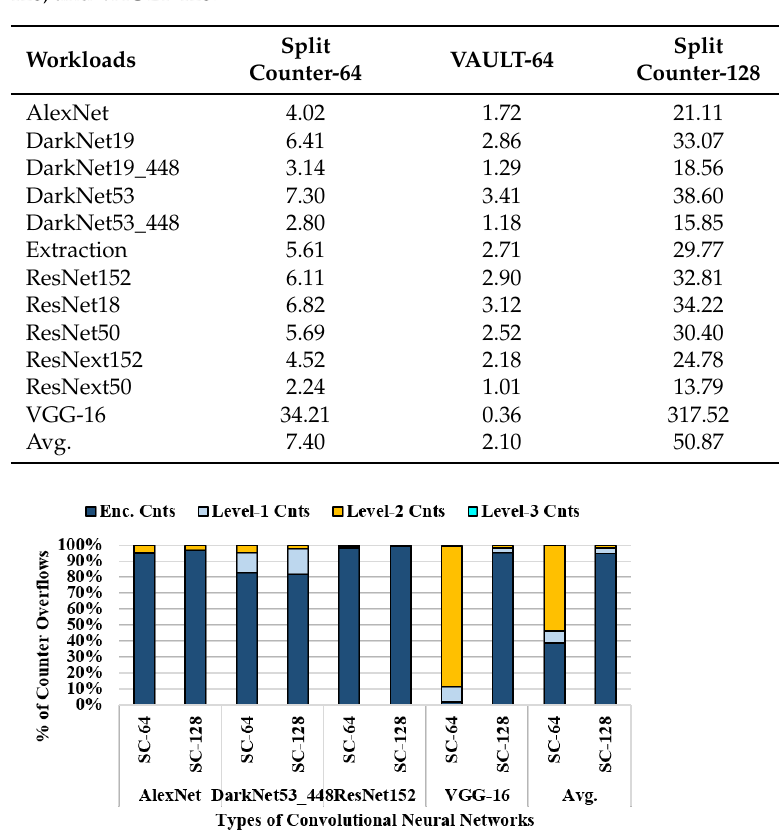
Table 2. Number of overflows per million instructions for split counter-64, VAULT-64, split counter- 128, and VAULT-128.